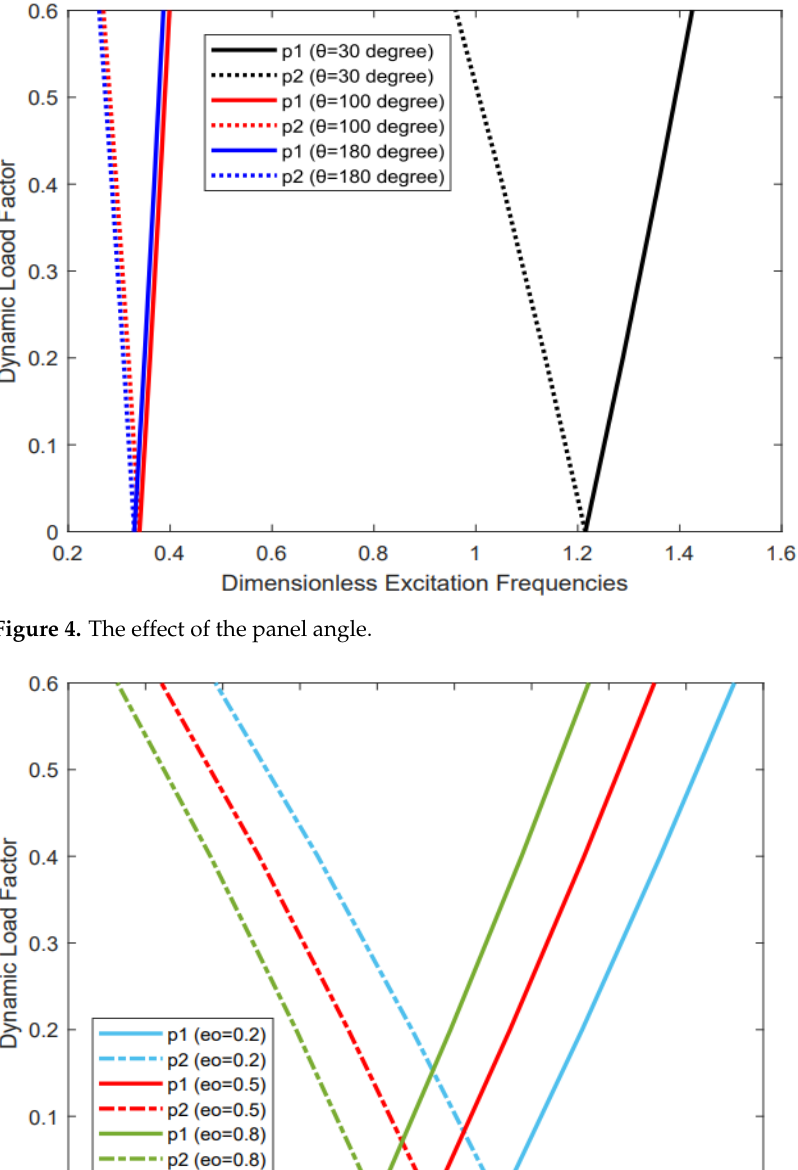
11 Figure 3. The effect of porosity distribution. 3.2.2. The Effect of the Panel’s Angle: The effect of the angle of the panels on the instability of the structure is shown in Figure 4, with the values of 01 N = 0.2, 0 e